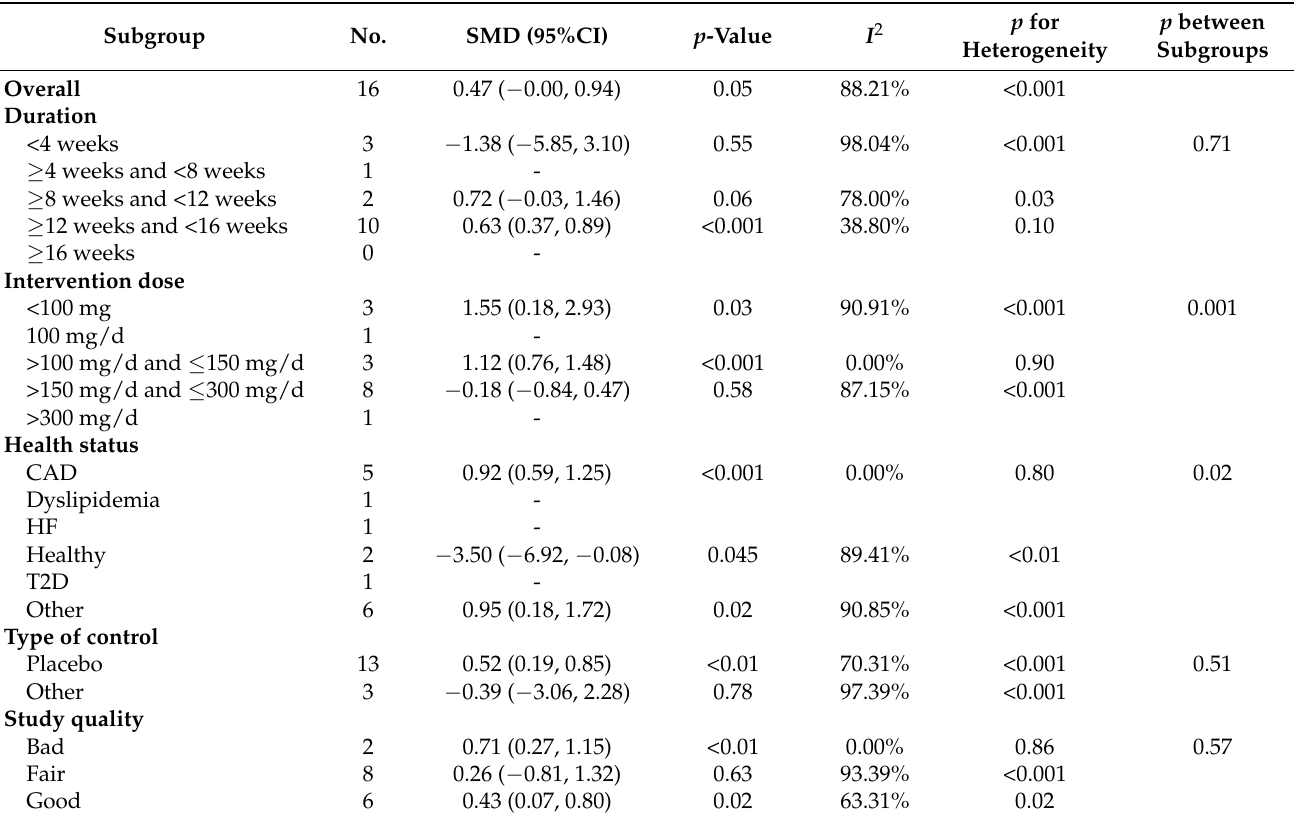
Table 4. Subgroup analyses of CoQ10 supplementation on SOD.